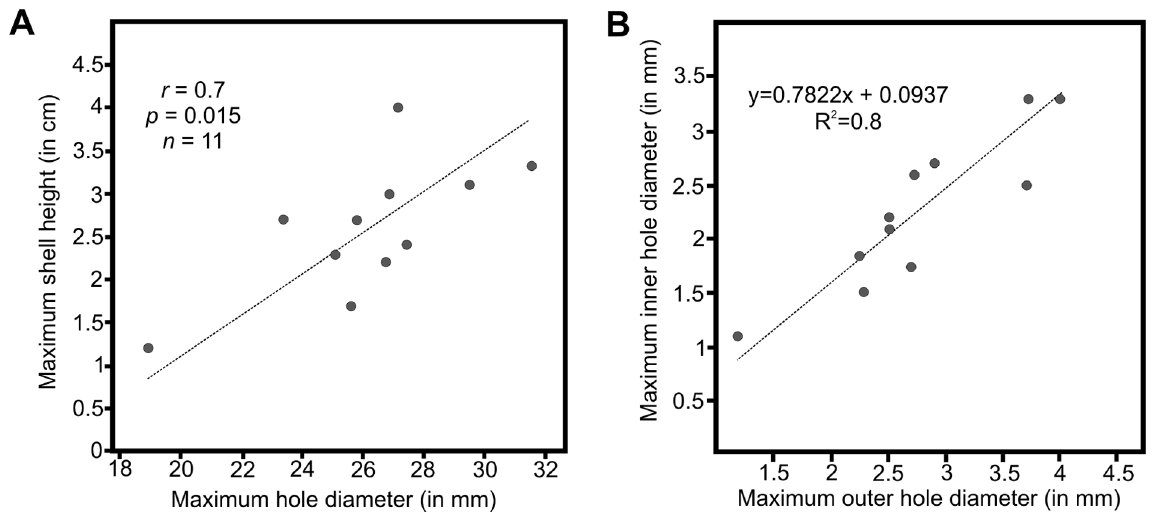
Figure 4. Scatter plots showing two types of correlations. ( A ) Correlation between hole size and shell size. ( B ) Correlation between the inner and outer hole diameter in Nassarius sp. Symbols for (A): r –Spearman rank correlation, p –probability of Type I Error for H [0]: r =0, n –sample